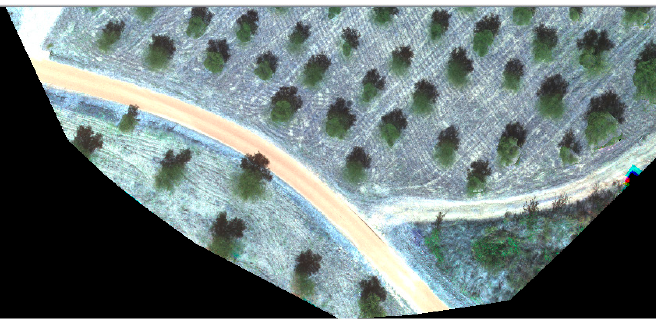
Figure 10. Representation of the road that cross the study area, which can influence the results.